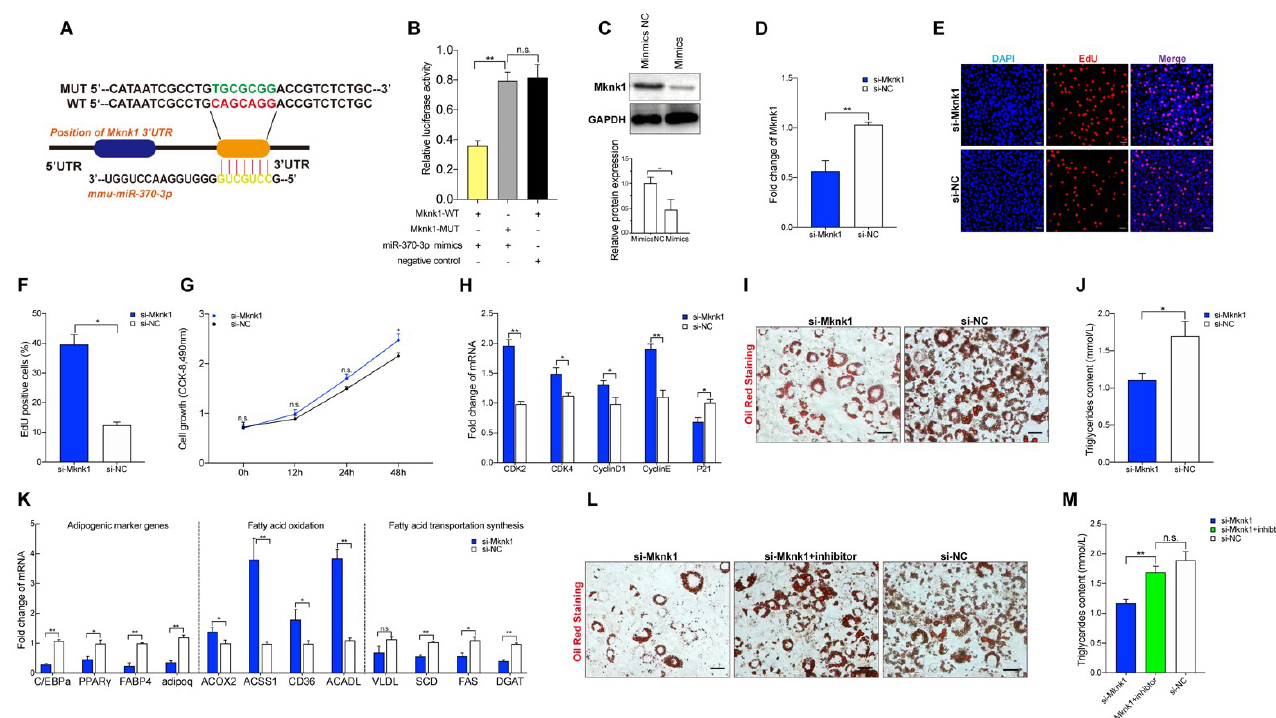
Figure 5. Mknk1 is a target gene of miR-370-3p. ( A ) Binding site and seed region of miR-370-3p are indicated in red. ( B ) Luciferase assays revealed the suppressive effect of miR-370-3p on the activity of Mknk1. ( C ) The protein expression level of Mknk1 48 h after transfection. ( D ) The expression levels of Mknk1 after cells were transfected with mimics, inhibitors, or NC. ( E , F ) EdU analysis, respectively. Moreover, ( G ) cell proliferation was evaluated at 0 h, 12 h, 24 h, and 48 h of proliferation by performing CCK-8. ( H ) qRT–PCR analysis of genes related to the cell cycle. ( I ) Cells were stained with oil red O. ( J ) Triglyceride content. ( K ) The expression levels of gene-related adipogenesis, fatty acid oxidation, and fatty acid transportation synthesis were measured by qRT-PCR. ( L ) Cells were stained with oil red O. ( M ) Triglyceride content. Scale bars 50 µ m. All results are presented as means ± SEM. n = 3 per treatment. Each treatment represents the mean of three replicates. * p < 0.05; ** p < 0.01, n.s. no significant